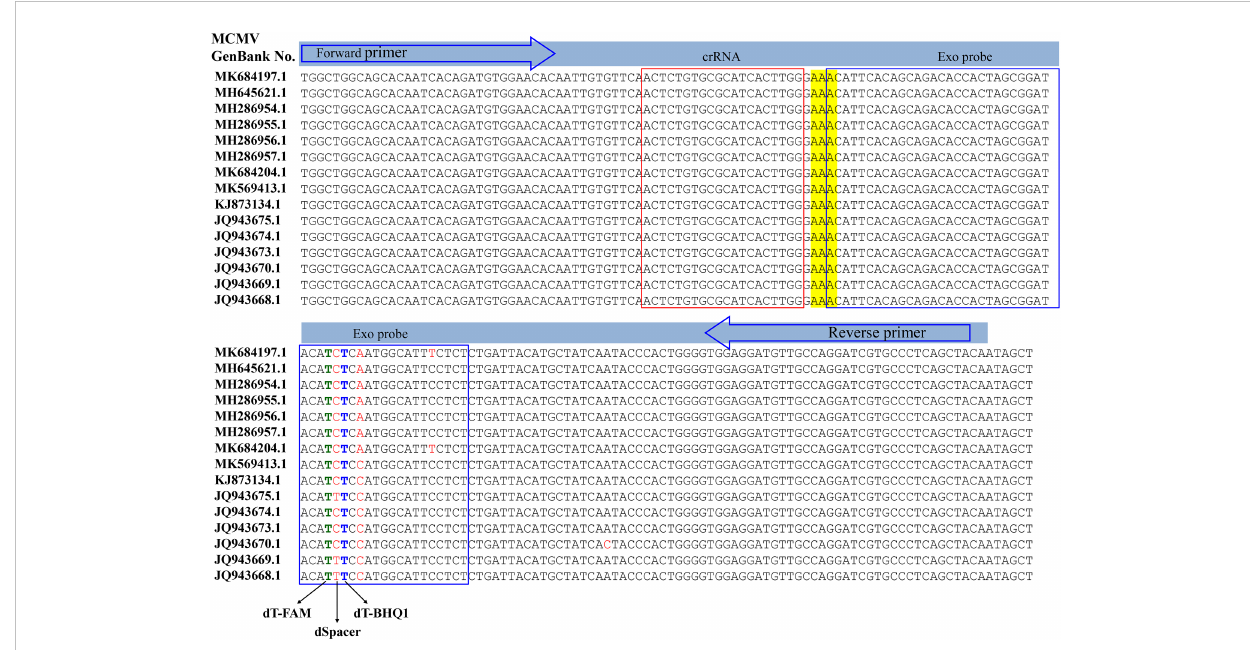
FIGURE 1 Design of the primer set and crRNA in the coat protein gene of